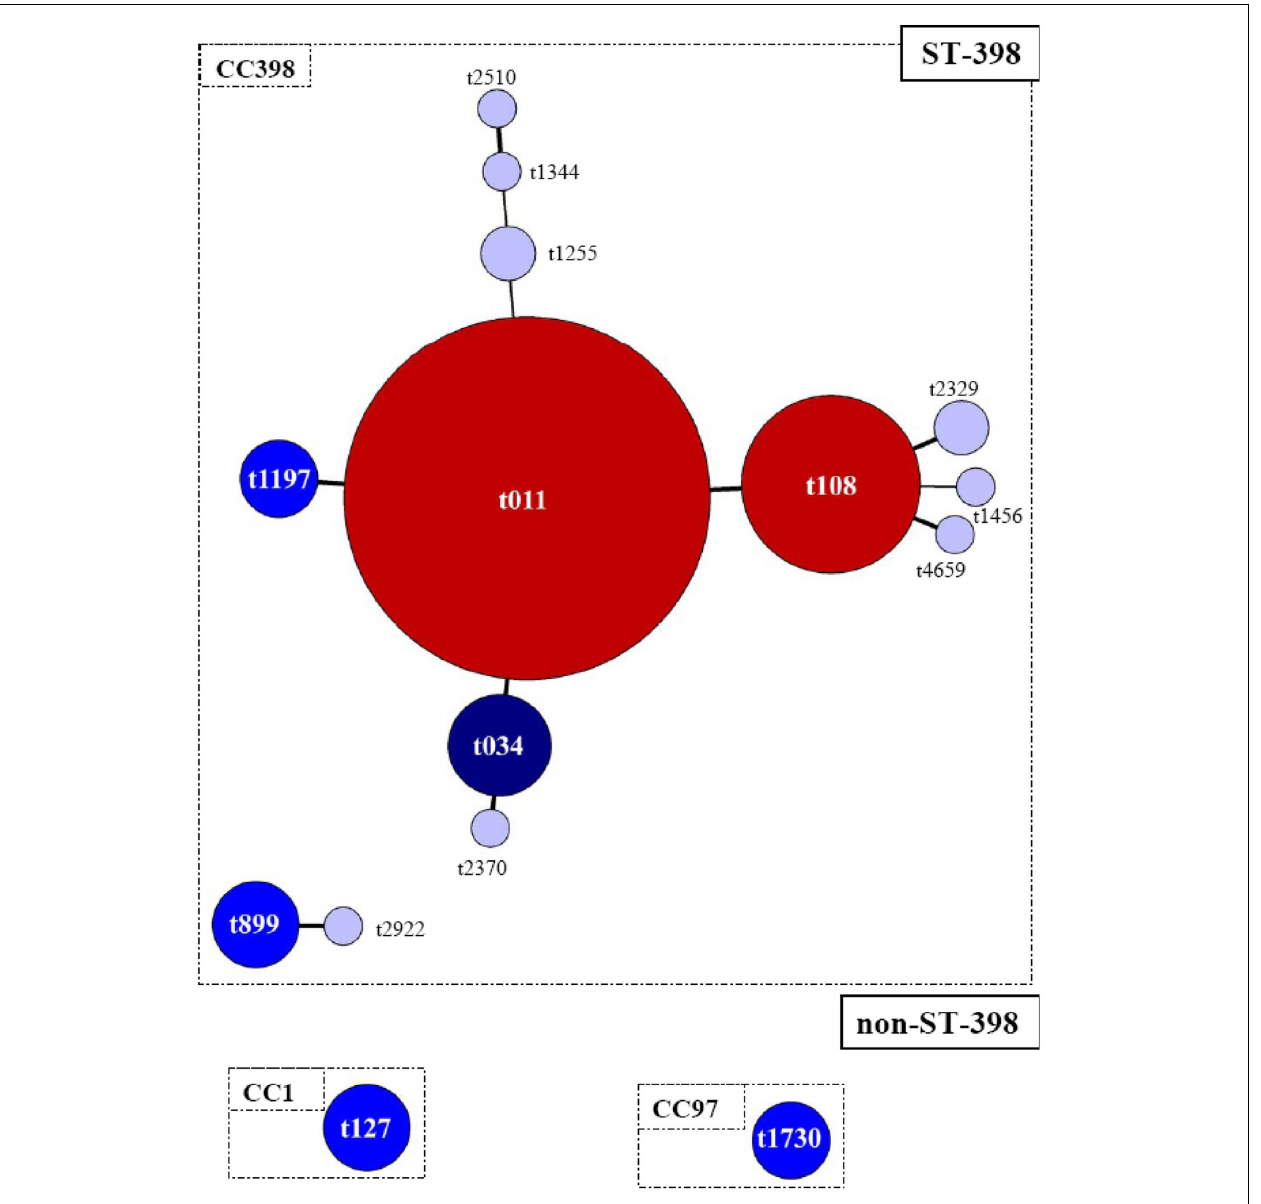
of the spa type indicated, from red (most frequent) to pale blue (less frequent). Reproduced from the EFSA J. with permission (European Food Safety Authority,